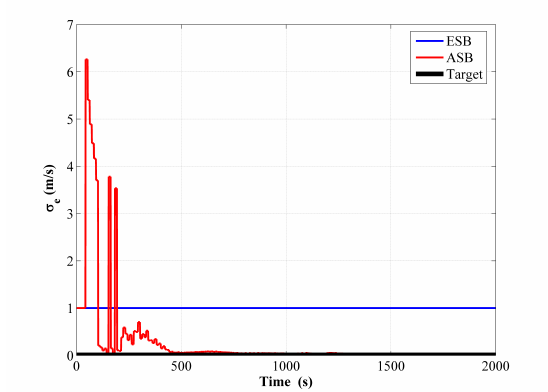
Figure 9. Estimated process noise comparison between the ESB and the ASB algorithms using simulation data with unknown Q k